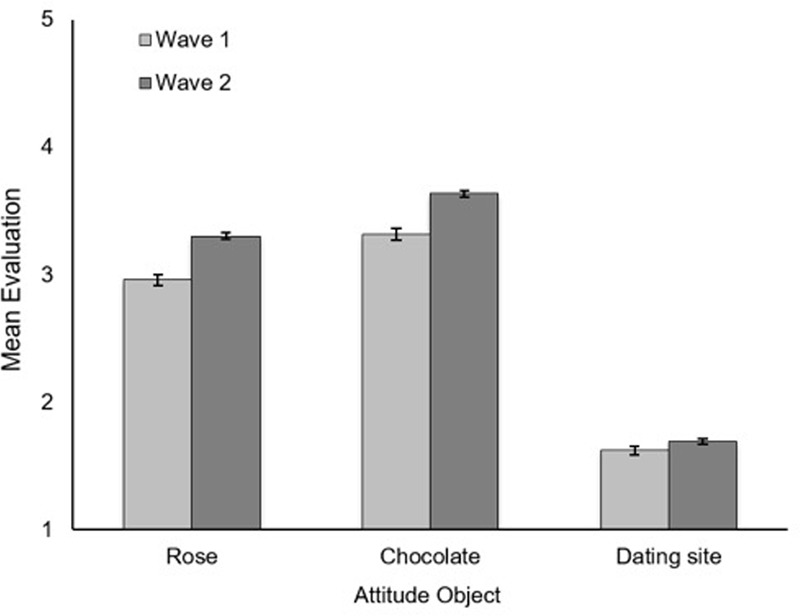
Bars represent mean evaluations of attitude objects (roses, chocolates, and online dating product) as a function of temporal proximity to Valentine’s Day (wave 1 [2/3–2/7] vs. wave 2 [2/12–2/14]). Evaluations were made on a scale from 1 (not at all) to 5 (extremely). Higher numbers reflect greater positivity. Error bars represent 95% CI.